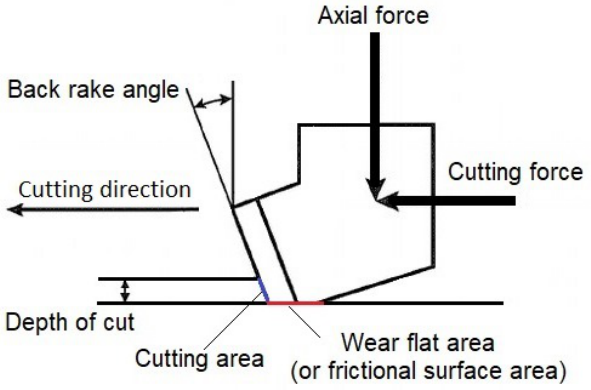
Figure 1. Geometry parameters for dull cutter.